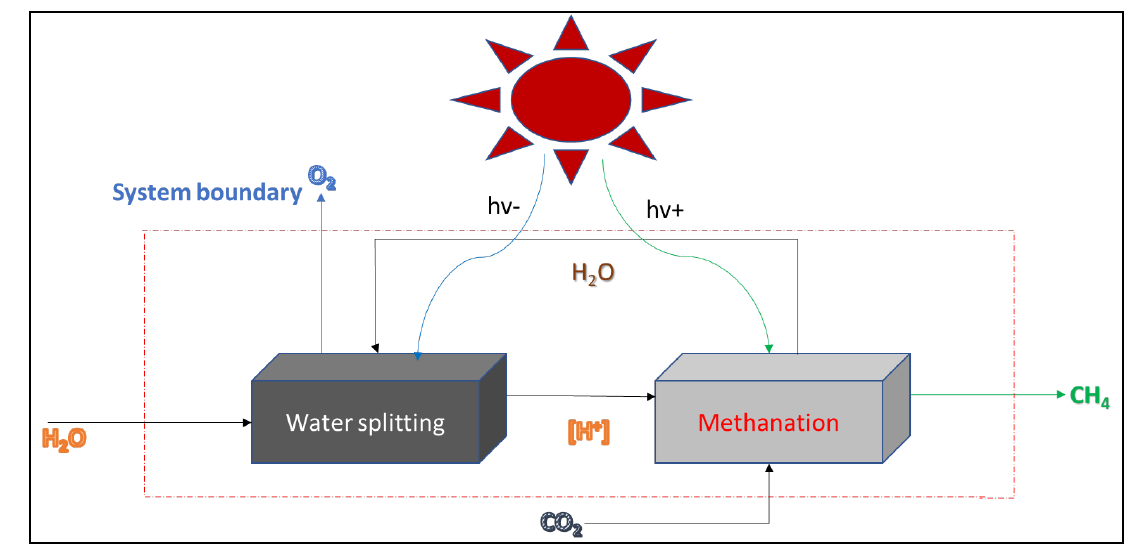
Figure 1. Schematic diagram of light-driven water-splitting with methanation CO 2 reduction.